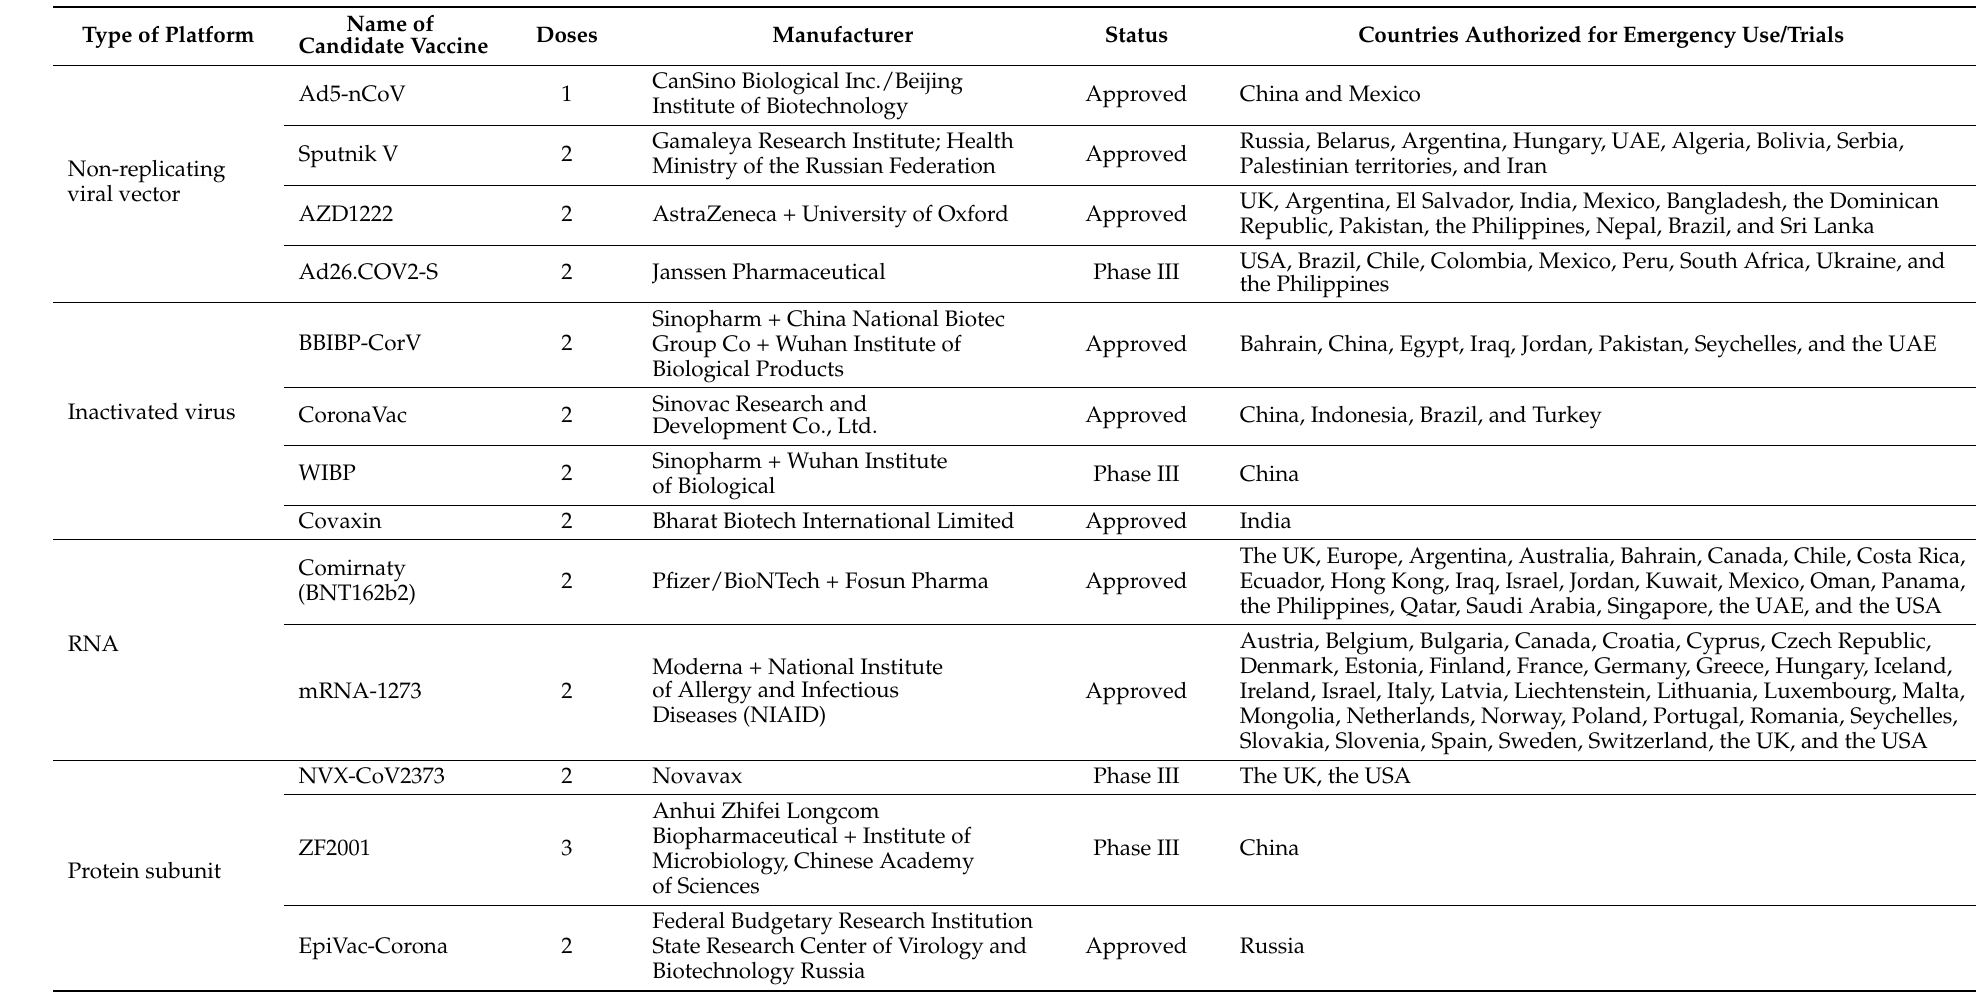
Table 6. Some of authorized/approved and candidate vaccines against SARS-CoV-2 (more details can be found at: https://www.who.int/emergencies/diseases/novel-coronavirus-2019 /covid-19-vaccines (accessed on 1 February